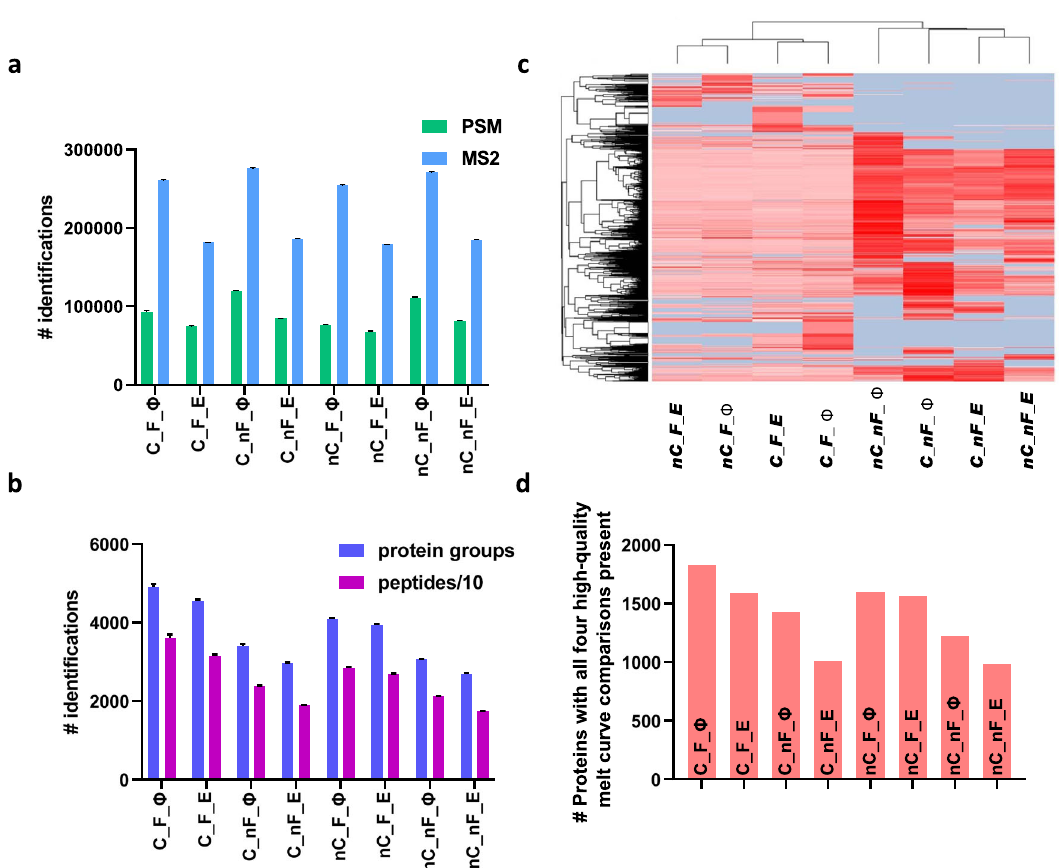
Fig. 3 iMAATSA performance evaluations. a Comparison of MS 2 and PSM identi fi cations for the evaluated approaches. b Protein group and peptide group identi fi cations in the assessed iMAATSA techniques. SIILCC, FAIMS, and Φ SDM increased both protein and peptide identi fi cations. c Heatmap and clustering (using Euclidean distance and complete linkage method) showing protein abundances from 126 reporter ion channel (37 ˚ C) in all iMAATSA approaches. Grey represents missing values. The iMAATSA without FAIMS display more missing values but, overall, a higher signal intensity compared to iMAATSA implementing FAIMS. d High quality melting curve comparisons for the iMAATSA approaches. The use of Φ SDM, FAIMS, and SIILCC produced the highest number of melting-curve comparisons and identi fi ed MEK1 and MEK2 as having a signi fi cantly shifted T m . The error bars represent the standard deviation ( n = 4) for panels a and